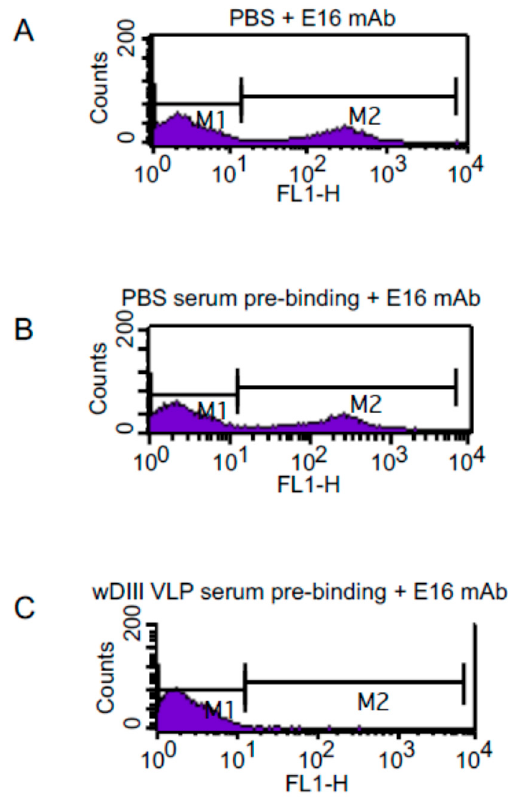
Figure 7. Competitive binding between the E16 mAb and antibodies in anti-HBcAg-wDIII serum to wDIII displayed on the yeast cell surface. wDIII-displaying yeast cells were pre-incubated with PBS ( A ) or week-11 pooled sera (1:1000 dilution) from mice either injected with PBS ( B ) or HBcAg- wDIII VLP ( C ). The E16 mAb was then incubated with yeast cells. The specific binding between E16 and yeast-displayed wDIII was measured by staining with an Alexa Fluor 488-conjugated goat anti-human secondary antibody and processing by flow cytometry.